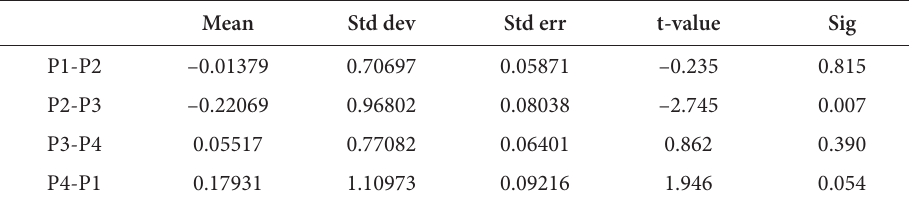
Table 4. Mean difference test for knowledge assessment of different